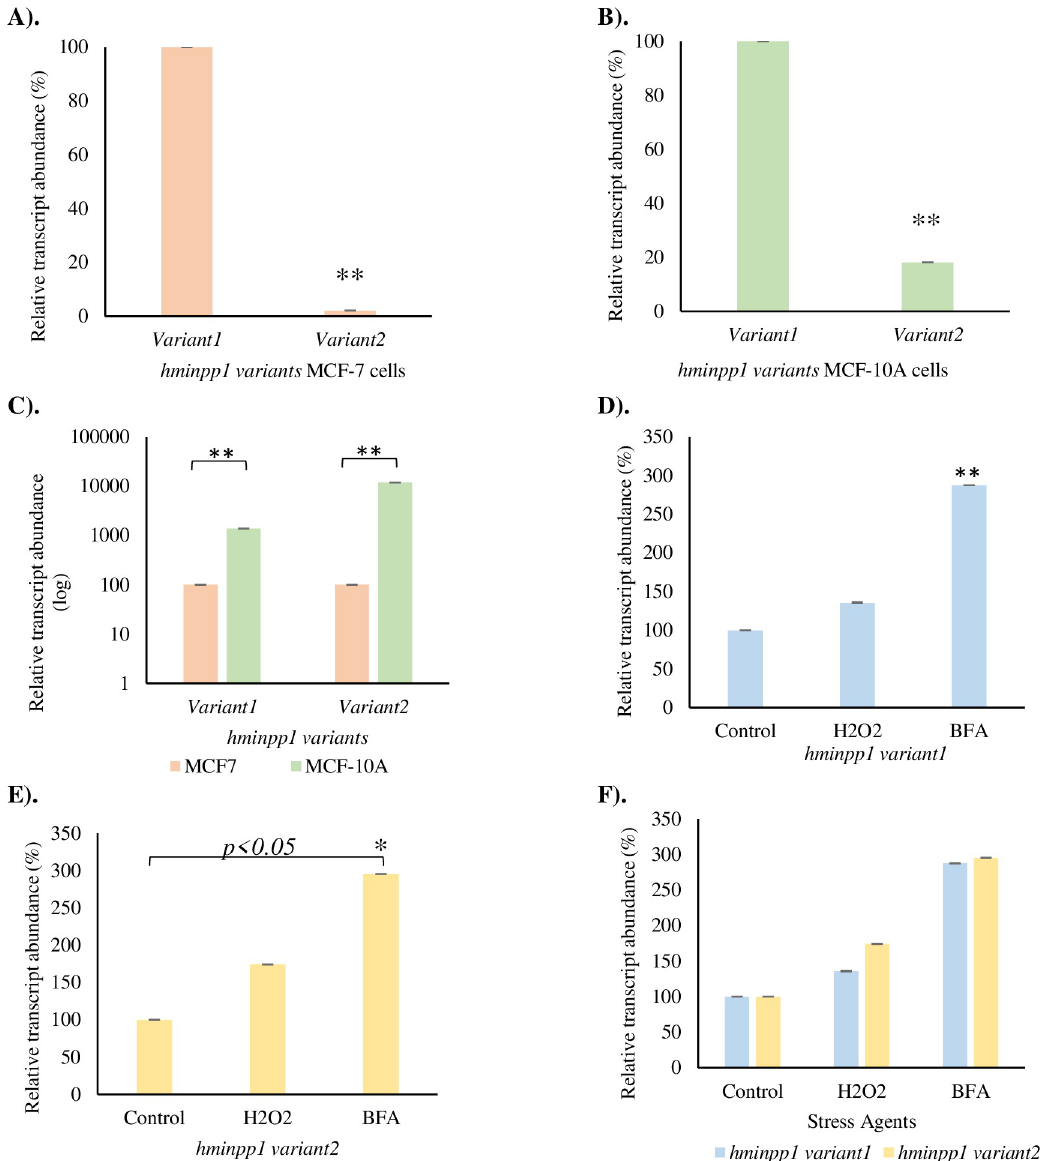
Fig 5. Expression profile of hminpp1 transcript variants by real-time PCR in A). MCF-7 breast cancer cells. B). MCF-10A normal breast cells. C). a comparative expression analysis of hminpp1 variants . hminpp1 variants expression is normalized to 100% in MCF-7 cells to better analyze each variant’s difference compared to MCF-10A cells. D). hminpp1 variant1 expression in MCF-7 cells under different stress conditions. E). hminpp1 variant2 expression in MCF-7 cells under different stress conditions, (p < 0.05) F). Comparative expression analysis of hminpp1 variant-1 and -2 under cellular stress. hminpp1 variant-1 expression is normalized to 100% in the control sample to analyze the relative difference in each variant better. Data, except in C, were converted into a percentage of control for better representation. Hydrogen peroxide (H 2 O 2 ): 100 μ M; BFA: 10.0 μ g/mL. Data reported as mean values of mRNA abundance after normalization with 18S gene expression. The error bars represent the standard error of the mean ( ± SEM). One-way ANOVA with post-hoc Tukey HSD (Honestly Significant Difference) was used to measure the significance between groups with significance p < 0 . 01 (A , B , C &, D) and p < 0 . 05